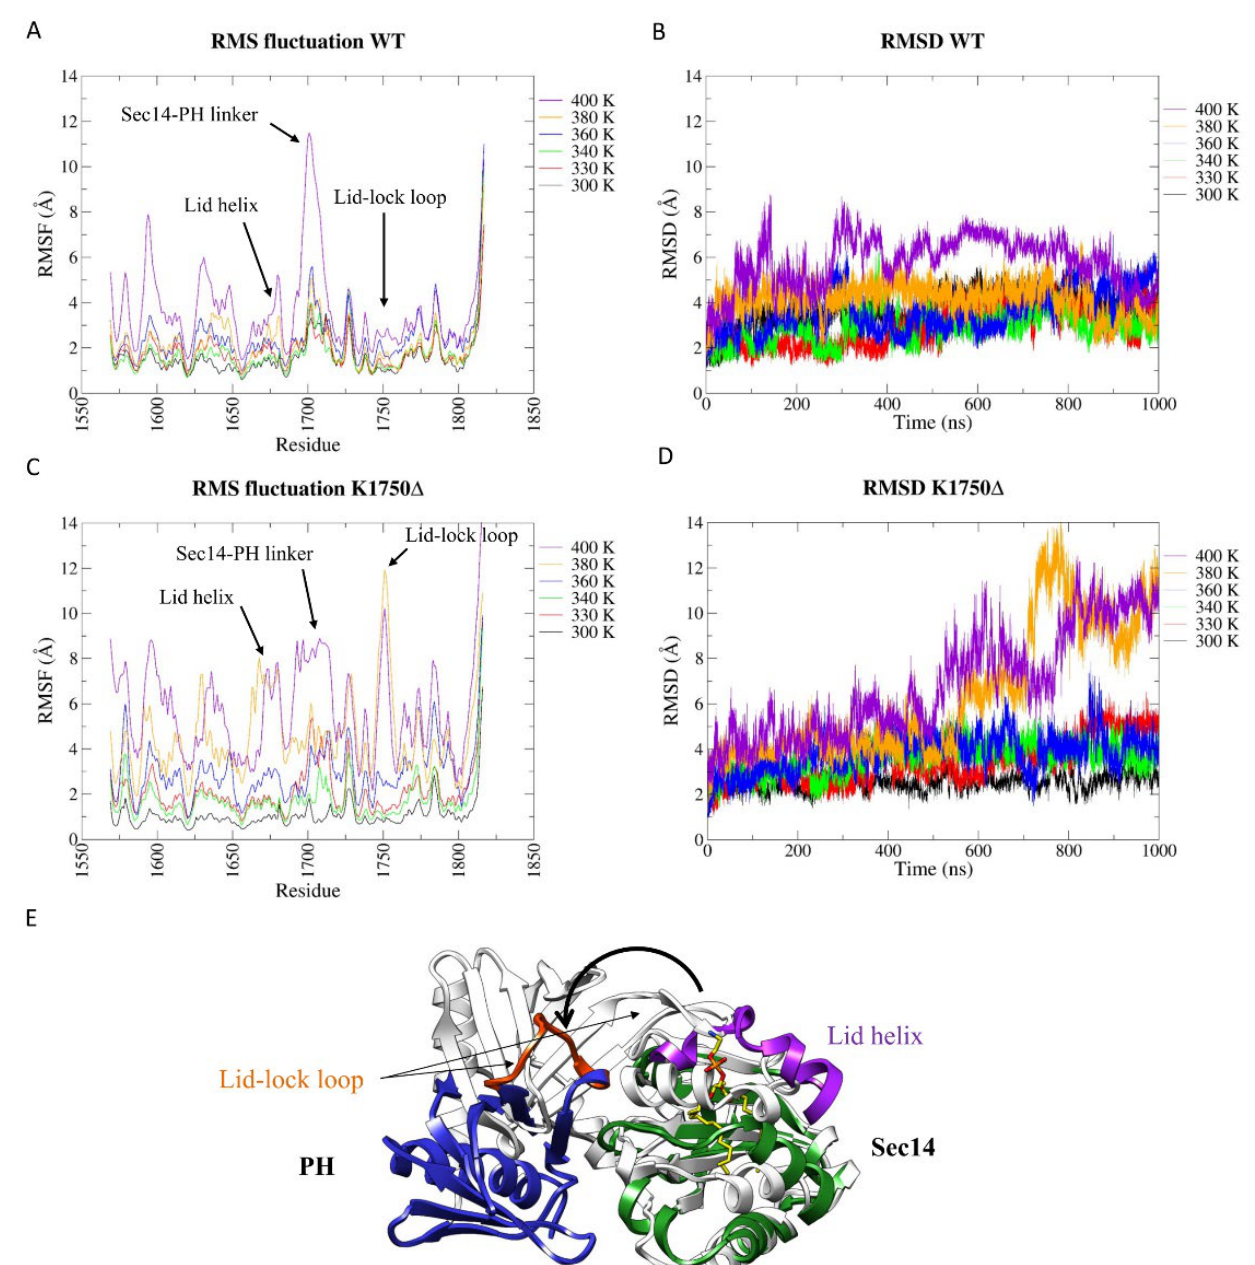
Figure 3. Analysis of MD simulations at increasing temperatures. ( A ) Root-mean-square fluctuation (RMSF) and ( B ) root-mean-square deviation (RMSD) of wt Sec14-PH domain. ( C ) Root-mean-square fluctuation (RMSF) and ( D ) root-mean-square deviation (RMSD) of K1750Δ mutant Sec14-PH domain. ( E ) A representative frame from the 380 K simulation of the mutant Sec14-PH domain. The lid-lock loop lost its secondary structure, and consequently, the PH portion detached from the Sec14 moiety.